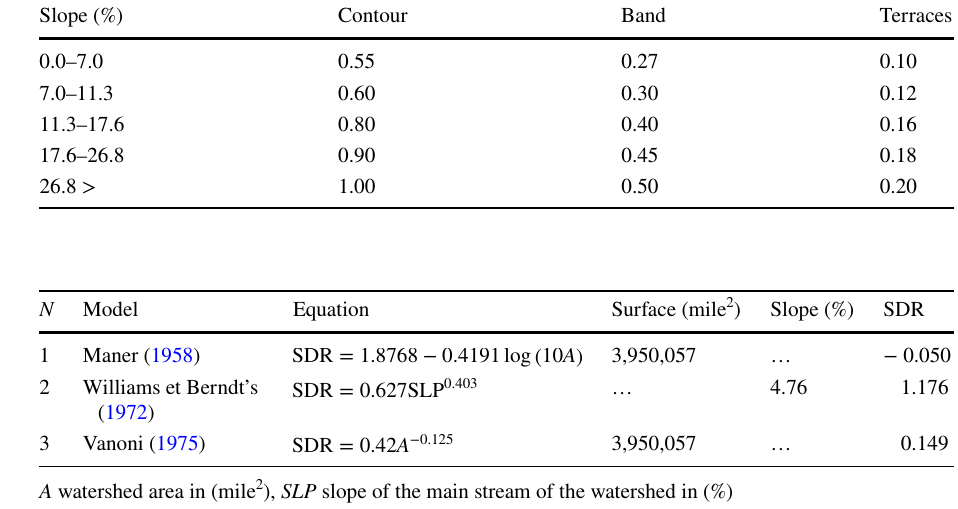
Table 3 Supporting practice factor values by crop type and slope (Shin and Pesaran